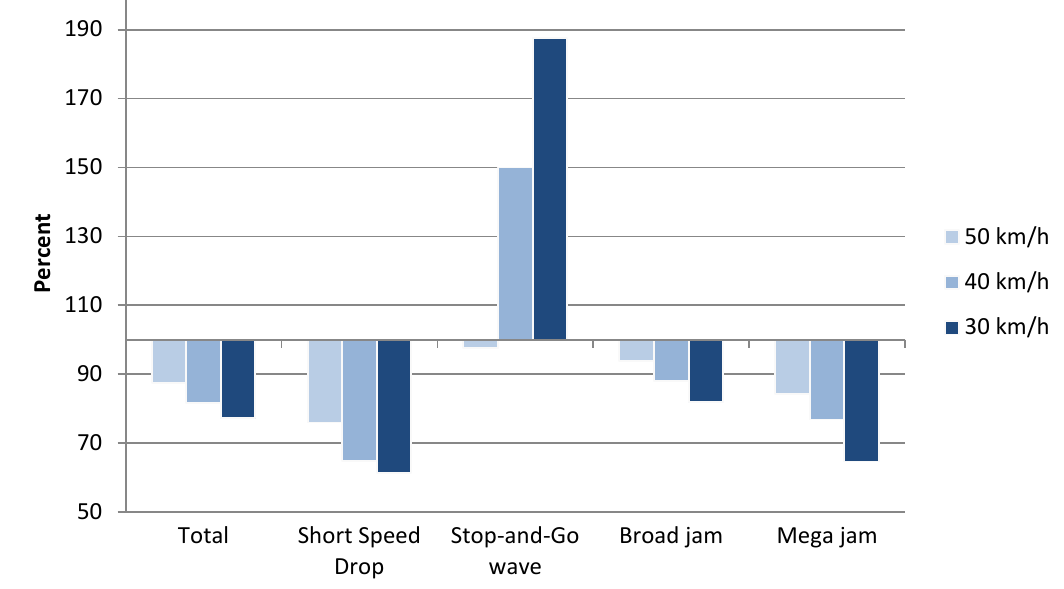
Figure 5. Percentage change in detected congestion classes depending on the speed threshold. (the reference threshold of 60 km/h equals